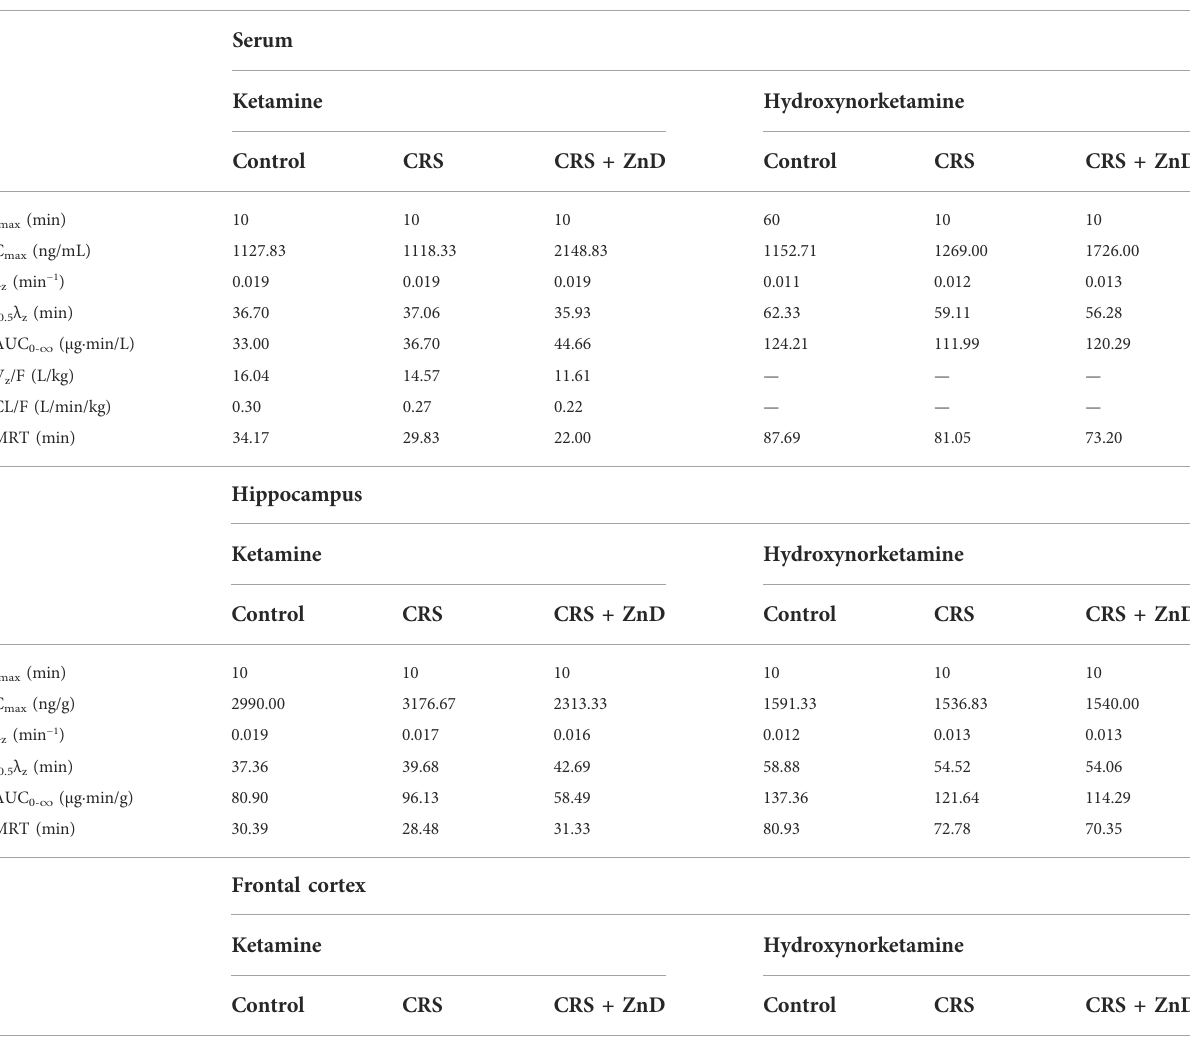
TABLE 1 Pharmacokinetic parameters of ketamine and hydroxynorketamine in mouse serum and brain structures estimated using noncompartmental analysis following administration of the parent drug at an i.p. dose of 10 mg/kg in the control and study groups.